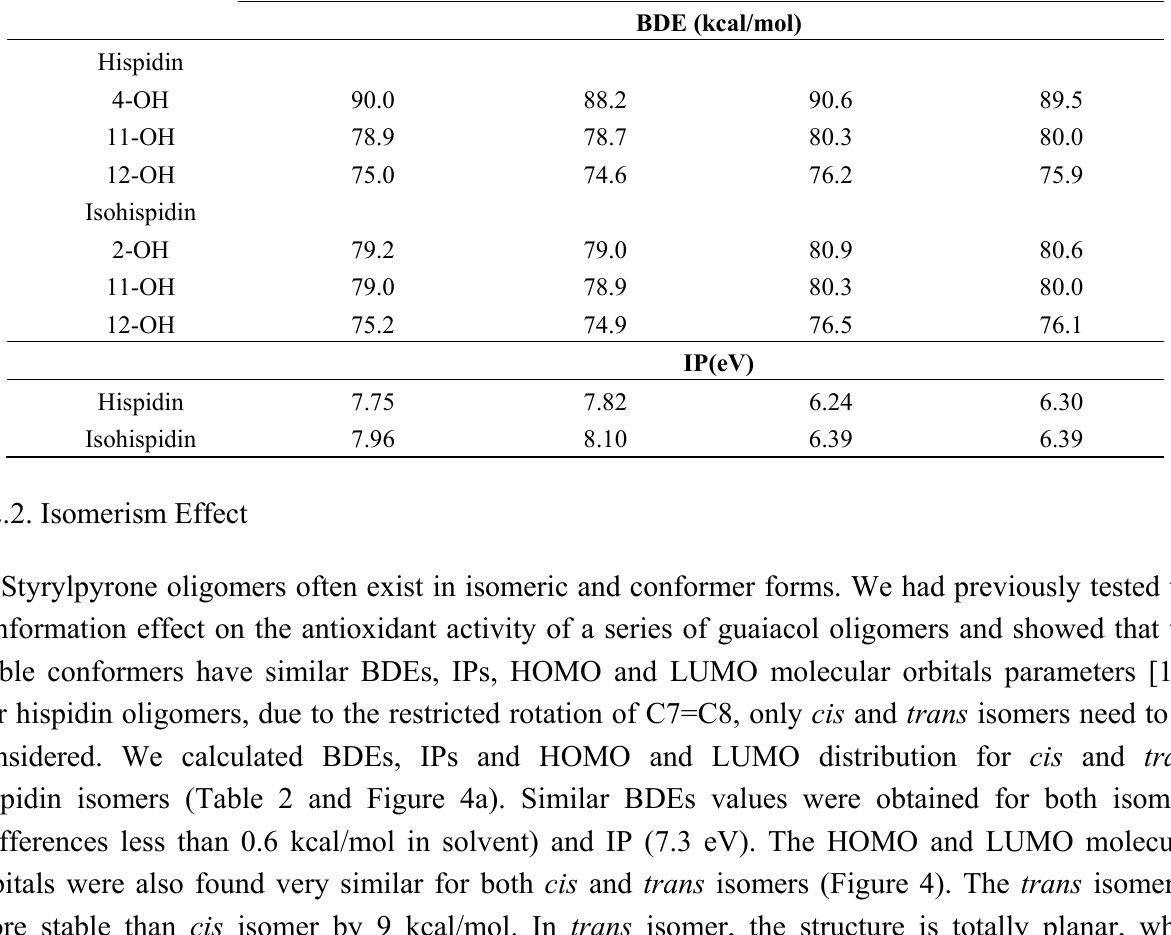
Table 1. BDEs and IPs of hispidin and isohispidin calculated using the B3P86 hybrid functionals and 6-31+G(d,p) and 6-311+G(d,p) basis sets.